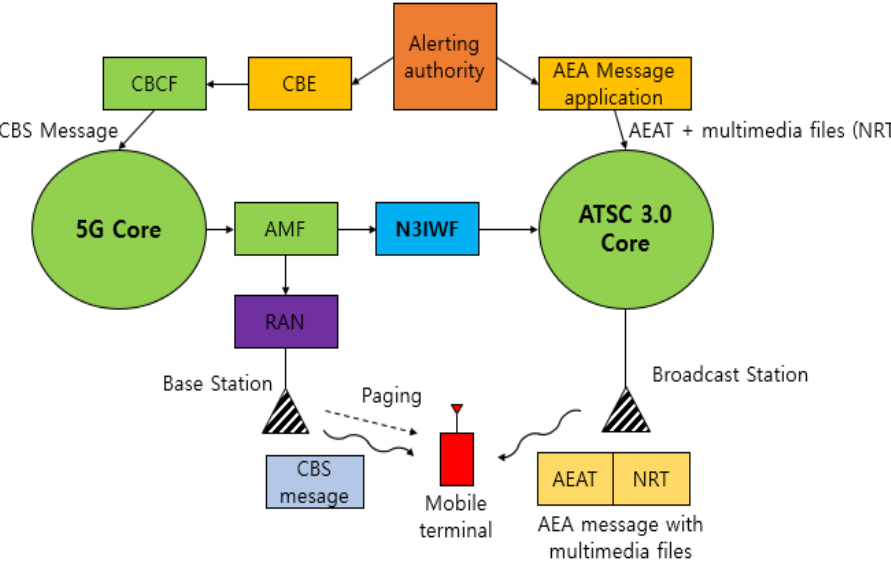
Figure 6. The overall architecture of the 5G and ATSC 3.0 convergence network for emergency alert alert broadcast.